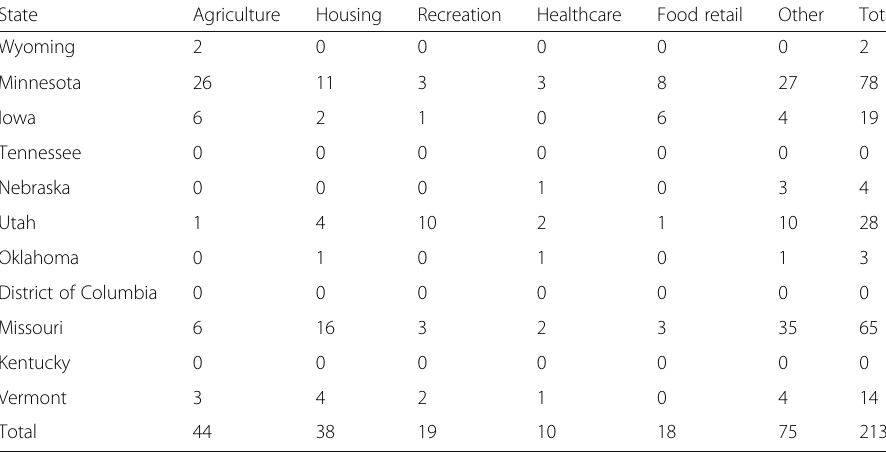
Table 3 Primary activity of active LCAs by state